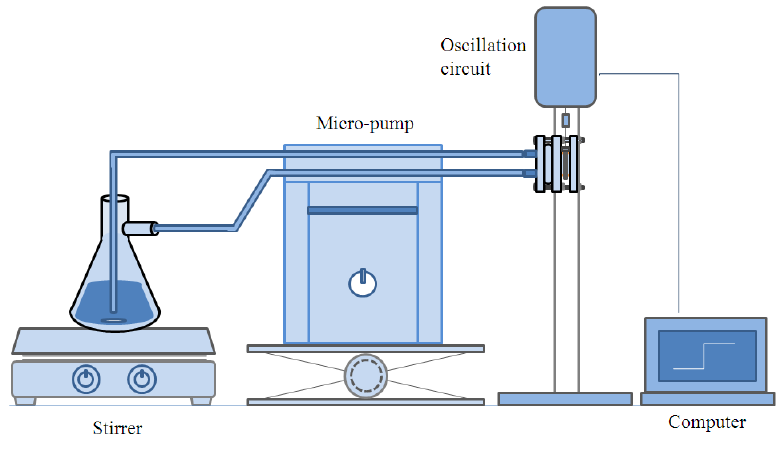
Figure 3. Schematic diagram of experimental setup for in-line